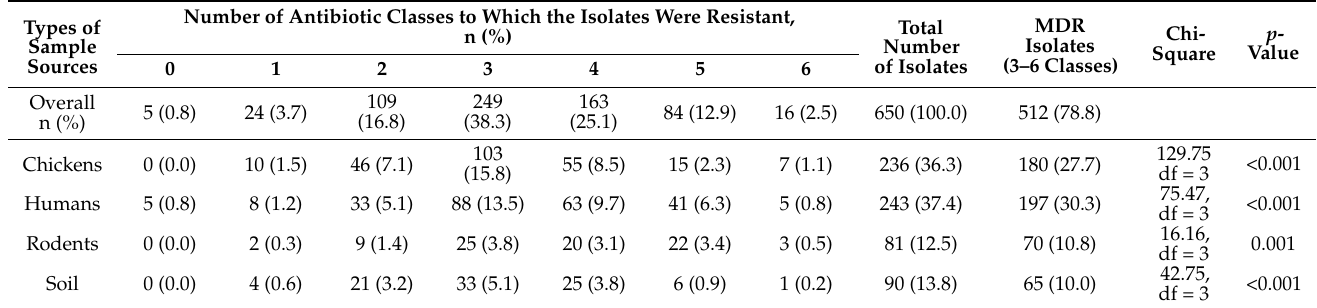
Table 2. Antibiotic resistance and MDR rates of Escherichia coli isolates from chickens, humans, rodents and soil samples.